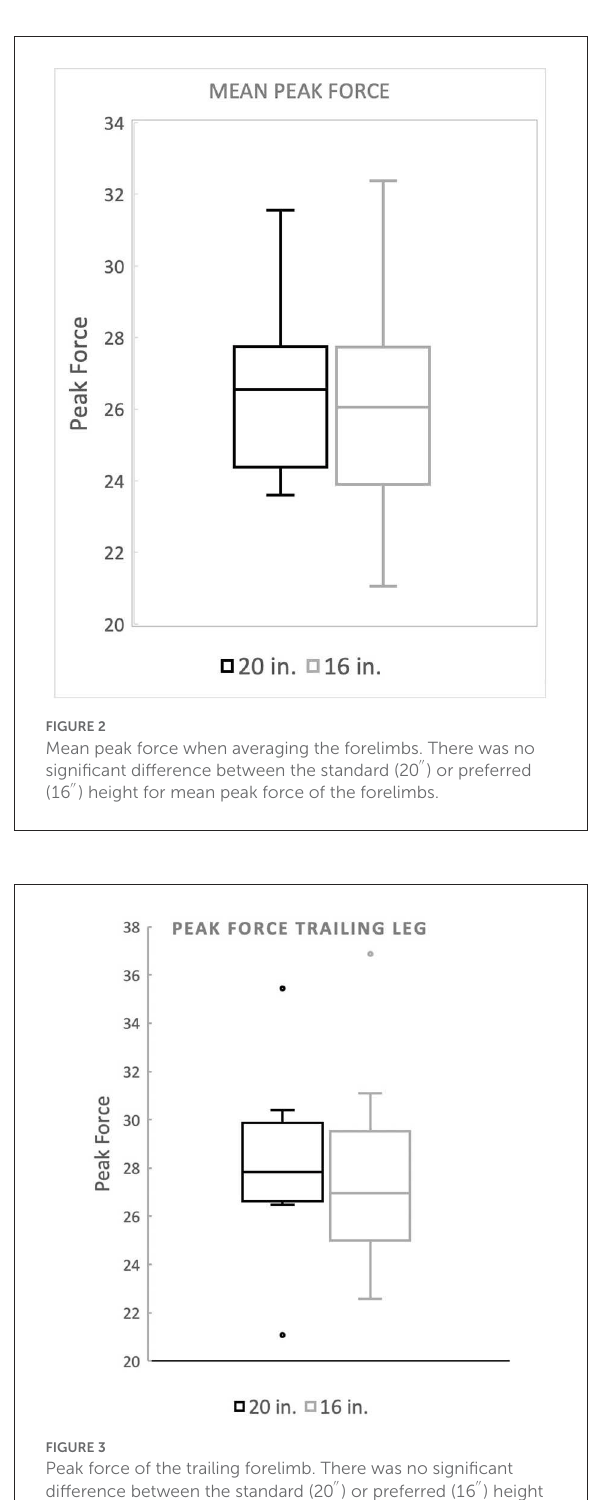
when controlling for velocity. These results suggest that the recommendation of decreasing jump height for older animals or and peak force on the forelimbs of dogs when jumping at a ′′ ′′ injured animals when performing the running bar jump may standard jump height (20 ) vs. a preferred jump height (16